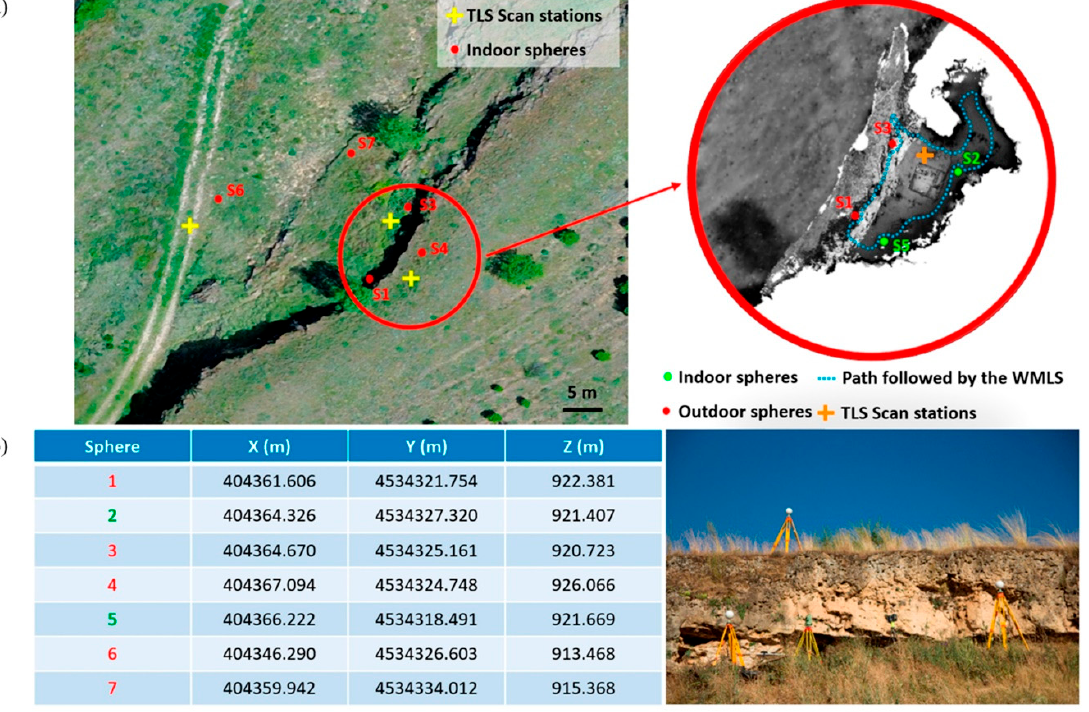
Figure 8. Network of registration spheres used to align the different point clouds: ( a ) plant view of the sphere network distribution and ( b ) a detailed view of the spheres used near the rock shelter entrance. The cross marks represent the different TLS scan stations carried out. The blue dash line represents the trajectory followed during the data acquisition by means of the WMLS.